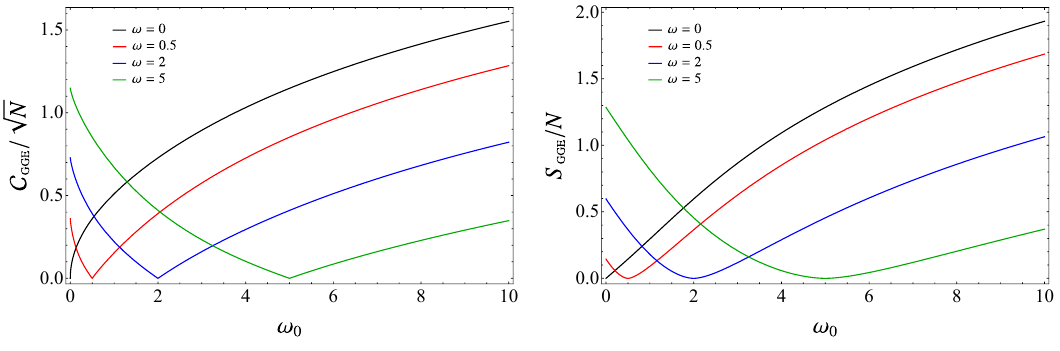
√ / N from (5.24) (left panel) and of S GGE